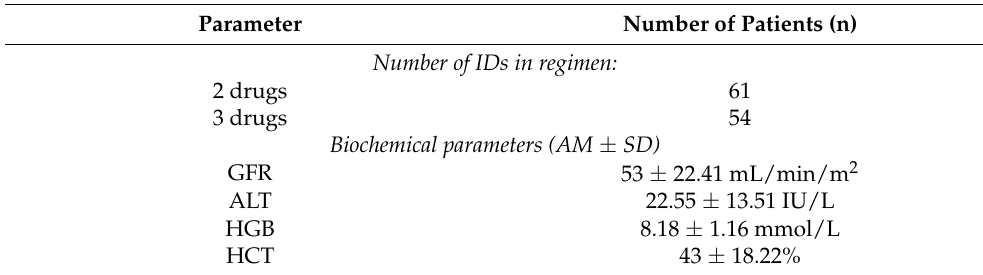
Table 1. Cont. Renal Transplant Recipients (n = 115), Stable Function of Graft > 6 Months Parameter